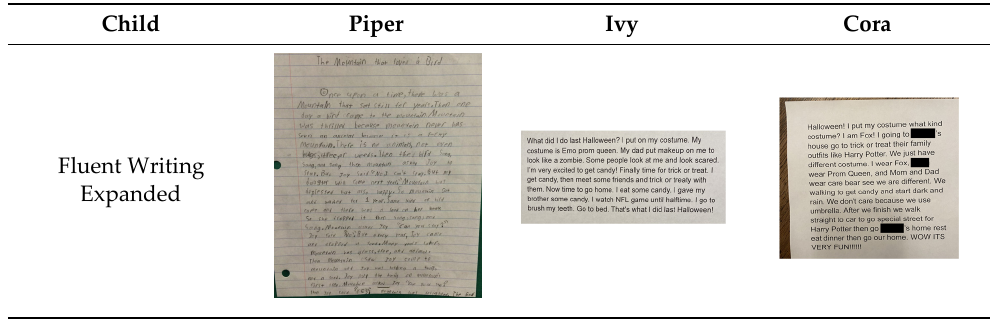
Table 6. Table 6. The Fluent Stage Expanded. Table 6. The Fluent Stage Expanded. Table 6. The Fluent Stage Expanded. Table 6. The Fluent Stage